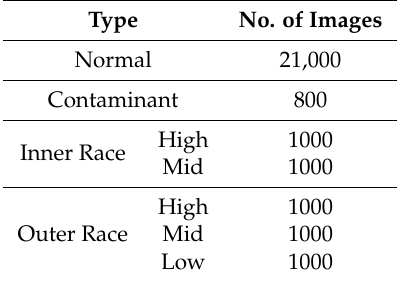
Table 1. Image data sets for motor